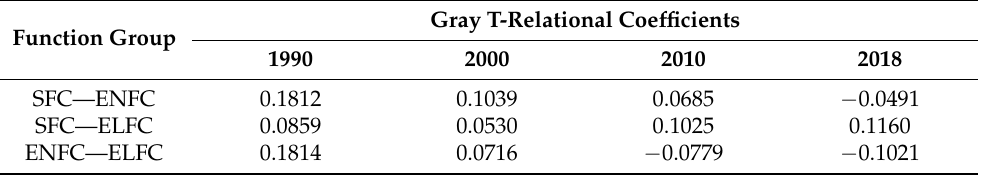
Table 2. Gray T-relational coefficients between CLFs in